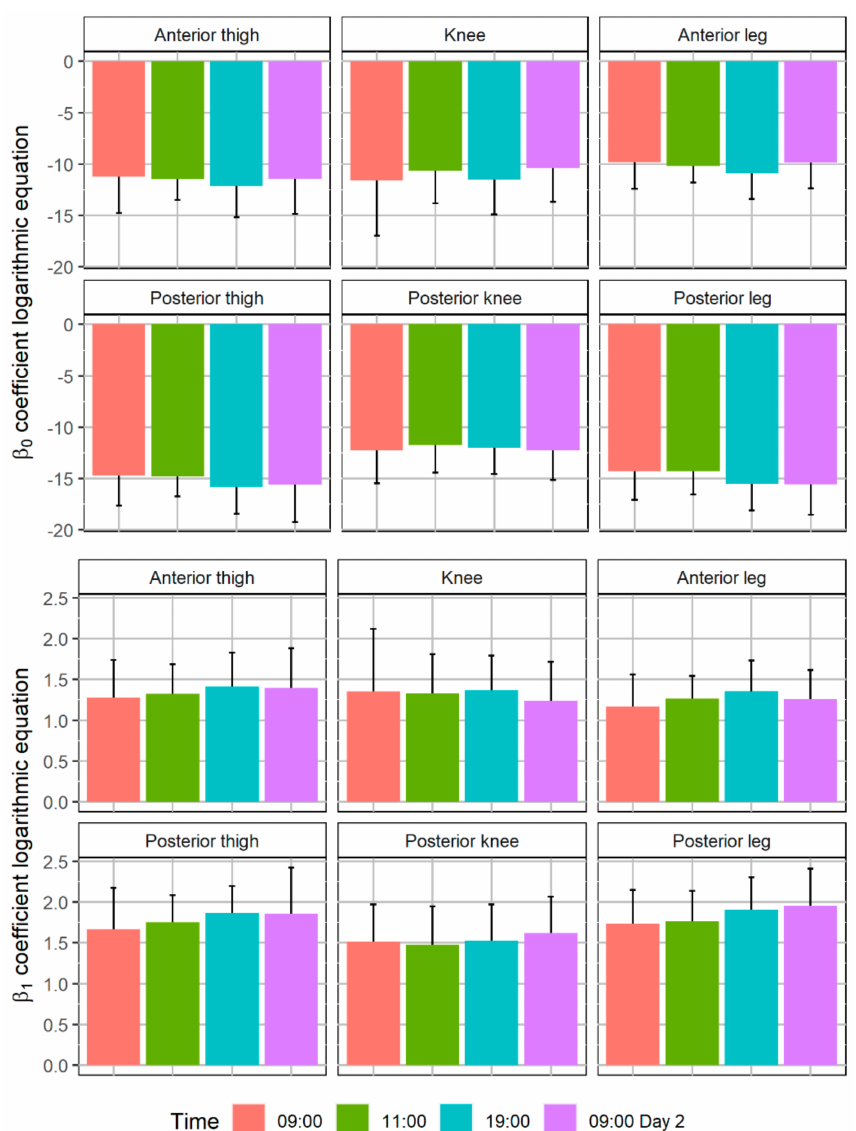
Figure 4. Mean and standard deviation of the coefficients of the logarithmic equations obtained with the cold stress test: Skin temperature variation ( ◦ C) = β 0 + β 1 × ln (T), where β 0 and β 1 are the constant and slope coefficients of the equation, respectively; ln is the natural logarithm; T is the time lasted after the cold stress in seconds; and skin temperature variation is the difference between the skin temperature at T respect with pre-cooling moment. No differences were observed between measurement times in each region of interest ( p >